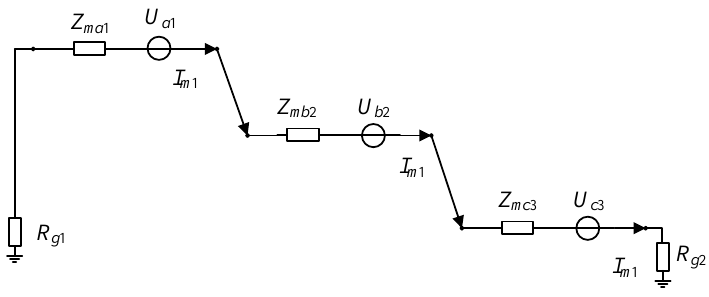
Figure 3. The equivalent circuit of sheath current in A1 – B2 – C3 section under normal operation. Since half of the leakage current flows in the same direction as the sheath circulating current and the other half is opposite to the sheath circulating current, it can be ignored in the calculation of the sheath grounding current under normal operation. When the short-circuit fault occurs, the equivalent circuit of the sheath current is changed, and the calculation method of the elements in the corresponding transmission line equation is also changed. During the short-circuit fault, the fault current flows from the core conductor into the metal sheath, and then flows to the ground through the metal sheath. A new current loop is formed between the core conductor and the metal sheath, and this current loop contains its own loop self-inductance and mutual inductance with other current loops. Taking the short-circuit fault in section A1 as an example, the equivalent circuit of the fault is shown in Figure 4, where U a represents the equivalent voltage source of the A-phase line, U A 1 S represents the induced electromotive force of the metal sheath section from G1 to